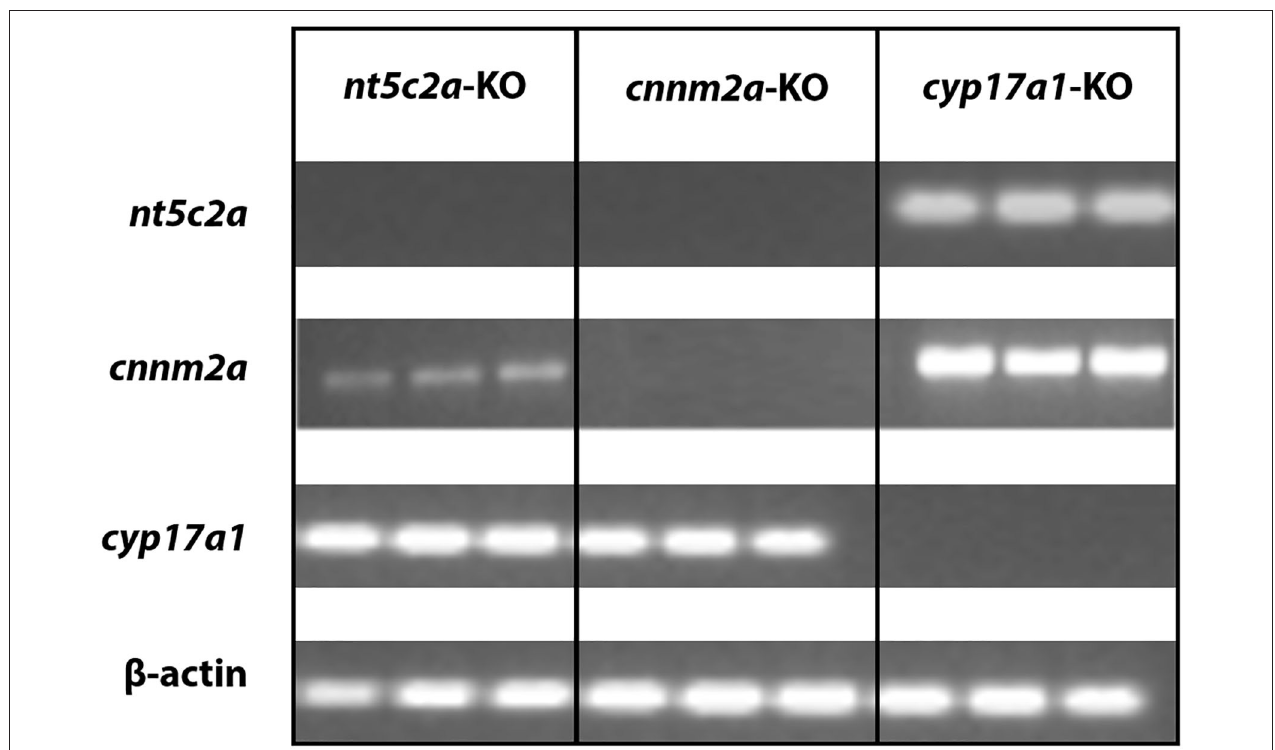
FIGURE 7 | Co-regulation of cnnm2 and nt5c2 genes. Agarose gel micrograph representing bands of DNA samples collected from cnnm2a, cyp17a1, and nt5c2a mutants. Each set of samples were investigated for expression of other genes along with house-keeping genes.